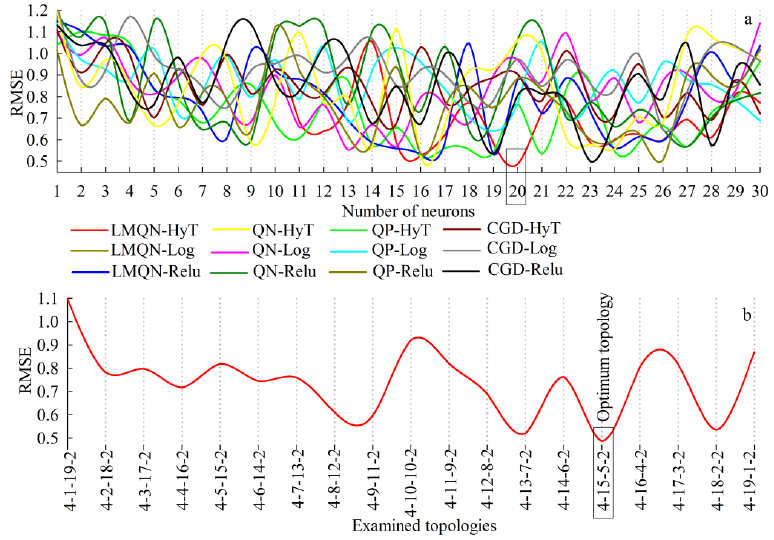
Figure 4. Performance of series monitored topologies as a function of RMSE subjected to different TA and AF ( a ), and examined topologies to find the optimum model corresponding to 20 neurons ( b ) ( TA → LMQN : limited memory quasi-Newton, CGD : conjugate gradient descent, QN : quasi-Newton, QP : quick propagation; AF → Log : logistic, Hyt : hyperbolic tangent, Relu : rectified linear unit).